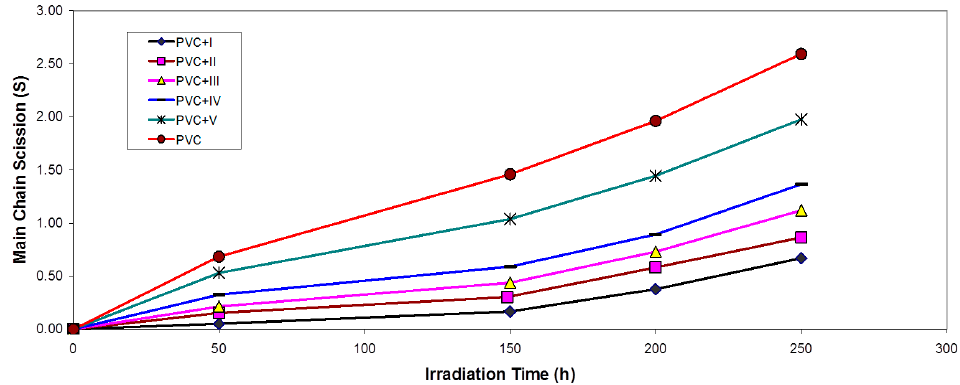
Figure 6. Changes in the main chain scission (S) during irradiation of PVC films (30 μ m) (control) and with 0.5 wt % of additives.